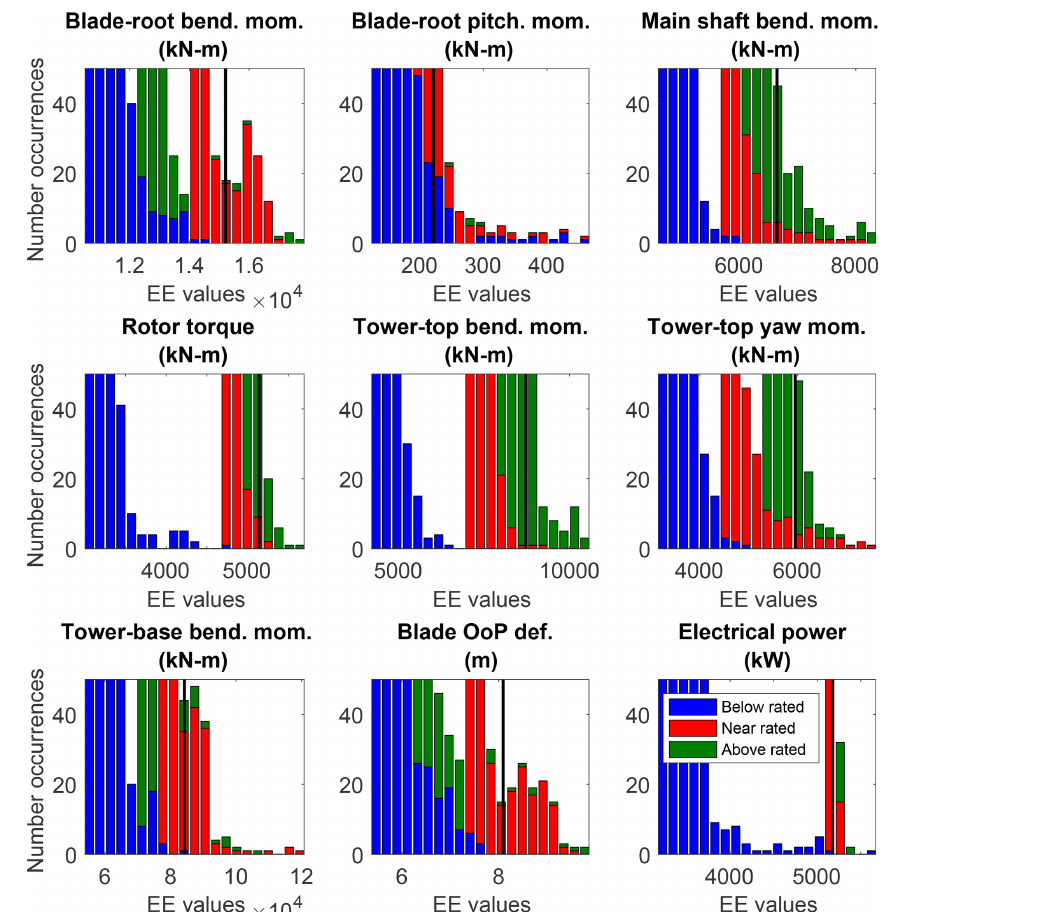
Figure 13. Zoomed-in stacked EE-value histograms of ultimate loads across all wind speed bins, input parameters, and simulation points for all QoIs. The black line represents the threshold by which outliers are counted for each QoI. Color indicates wind speed bin (blue is below-rated speed, red is near-rated speed, green is above-rated